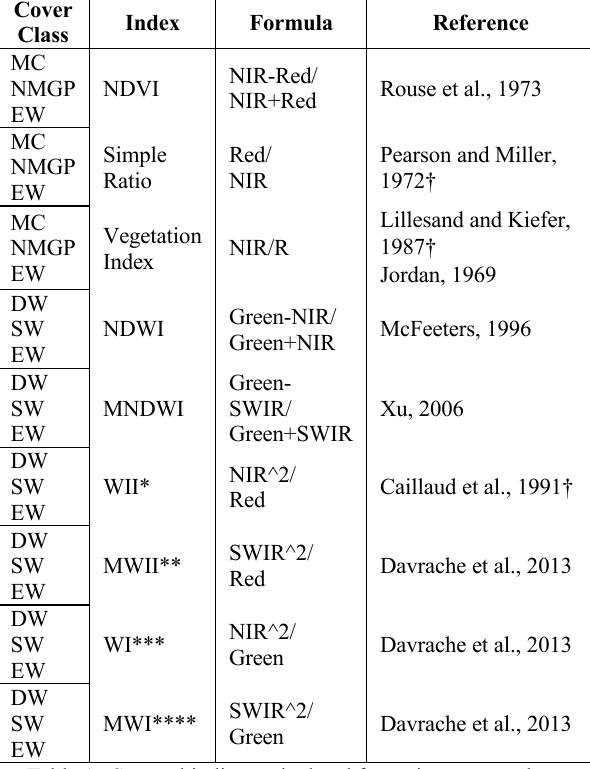
Table 1. Spectral indices calculated for a given cover class.